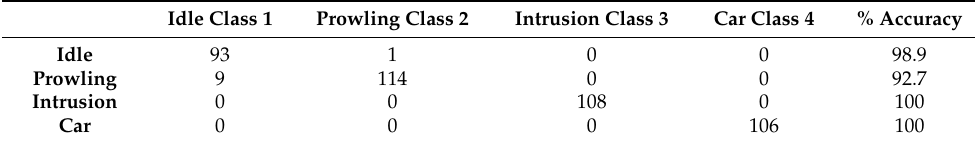
Table 1. Ensemble performance